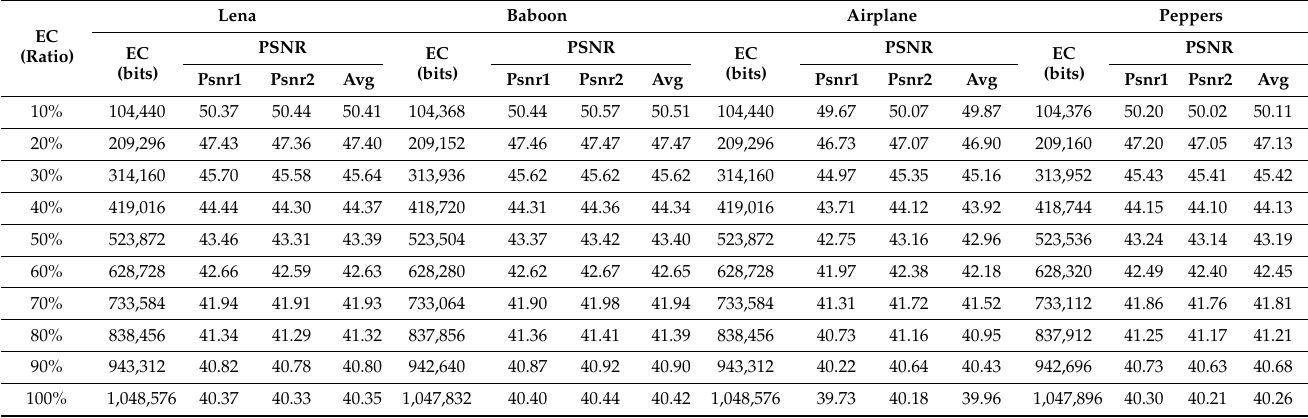
Table 5. Comparison of embedding capacity and PSNR value of different stego images for n =